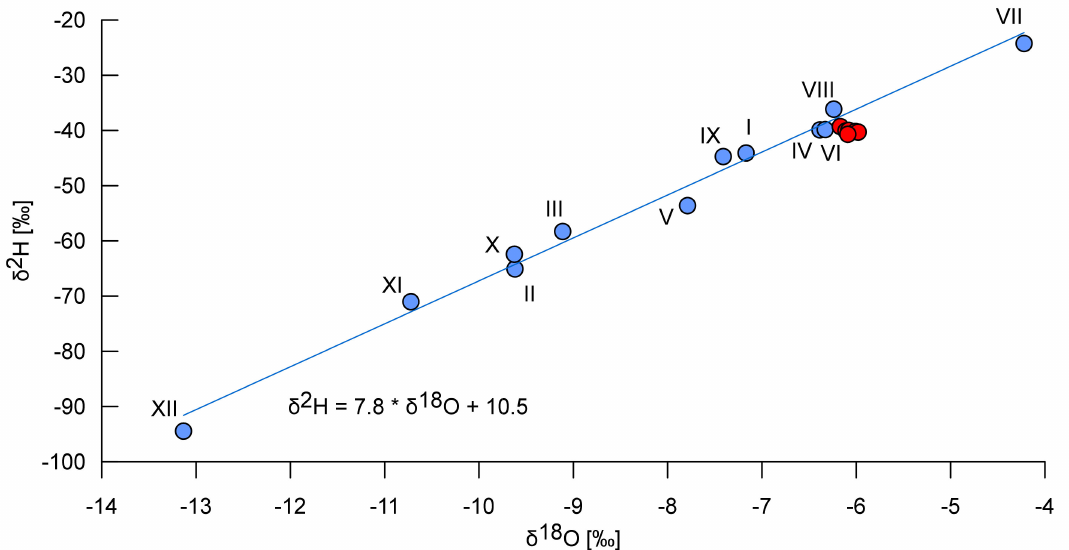
Figure 3. Isotopic composition of the mean monthly precipitation (the blue symbols) at Postojna calculated as weighted averages from monthly samples collected between September 2015 and November 2017 (the Roman numerals indicate months) with the equation of the local meteoric water line, and isotopic composition of the Reka River’s water in July and August 2017 (red dots). Table 2. Physicochemical and microbiological analyses of the Smrdljivec spring and the Reka River. Water Body